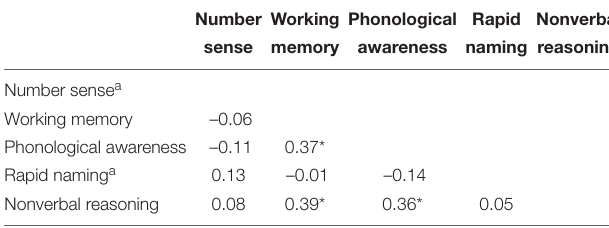
TABLE 2 | Correlations between the cognitive skills ( n = 262). Number Working Phonological Rapid Nonverbal